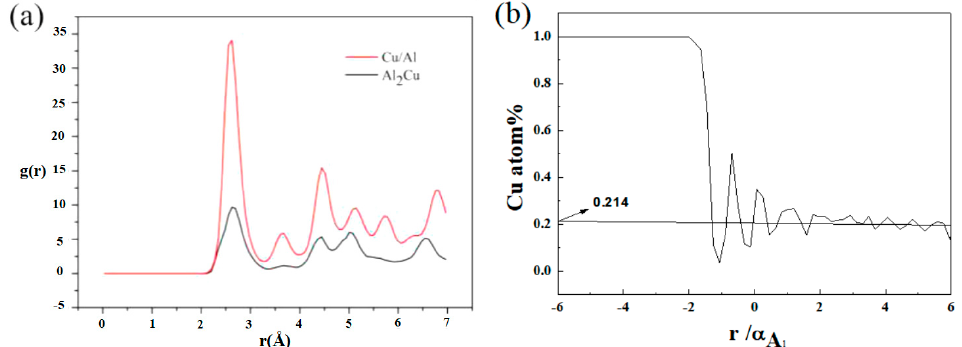
Figure 3. ( a ) Radial distribution function; ( b ) mole ratio of Cu atoms of Cu/Al composite panels model and CuAl 2 at 300 K.